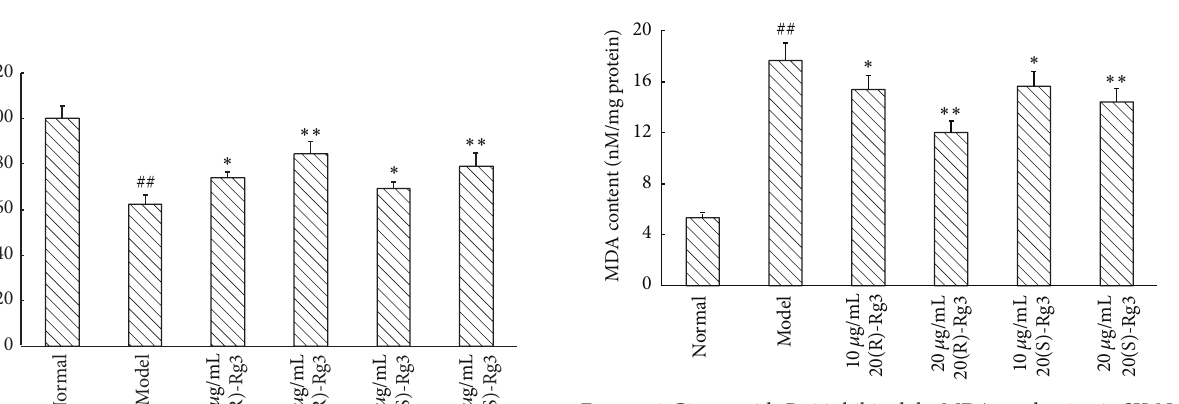
Figure 6: Ginsenoside Rg3 inhibited the MDA production in SK-N- SH cells. ## 𝑃 < 0.01 versus normal group, ∗ 𝑃 < 0.05 , and ∗∗ 𝑃 < 0.01 versus model